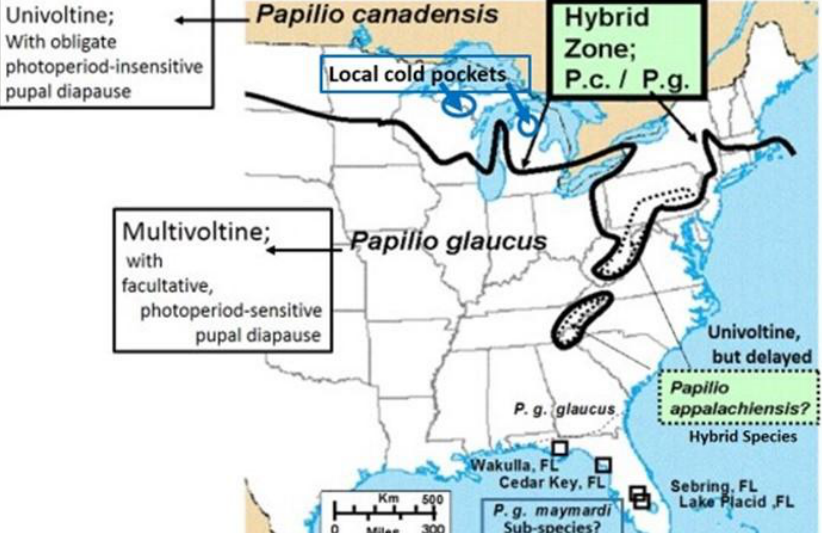
Figure 2. The historical tension zone of hybrid interactions across the North American Great Lakes region and down the Appalachian Mountains [326,329]. The dotted line delineates the geographic locations of the type specimens for the hybrid species, P . appalachiensis [26,99]. A purported subspecies ( P . g . maynardi ) occurs south of